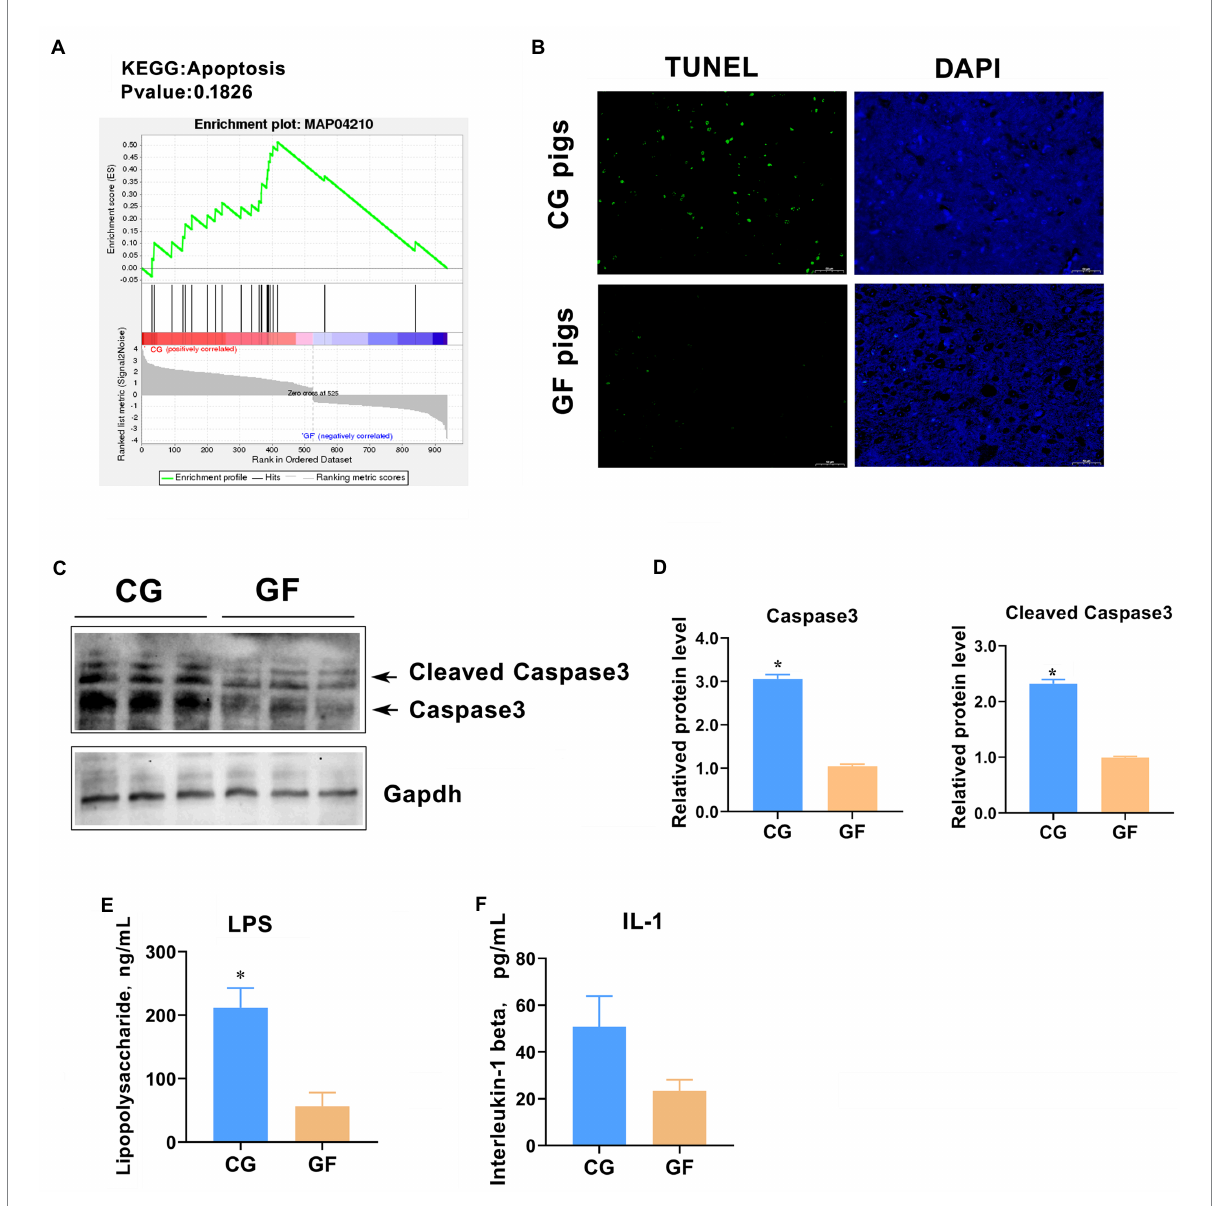
FIGURE 9 Hypothalamic cell apoptotic level between groups. (A) Apoptosis enrichment indicated by GSEA. (B) TUNEL analysis of cell apoptosis in the hypothalamus. Green color indicates TUNEL-positive cells. (C) Western blotting analysis of total and cleaved Caspase3. (D) Quantitative analysis of the protein levels of total and cleaved Caspase3. (E) Blood concentration of bacterial lipopolysaccharide (LPS). (F) Blood concentration of interleukin-1 (IL-1). The data are presented as the means ± SEM. *indicates p < 0.05 between CG pigs and GF pigs. n = 4 for the detection of LPS and IL-1 concentrations and n = 3 for WB